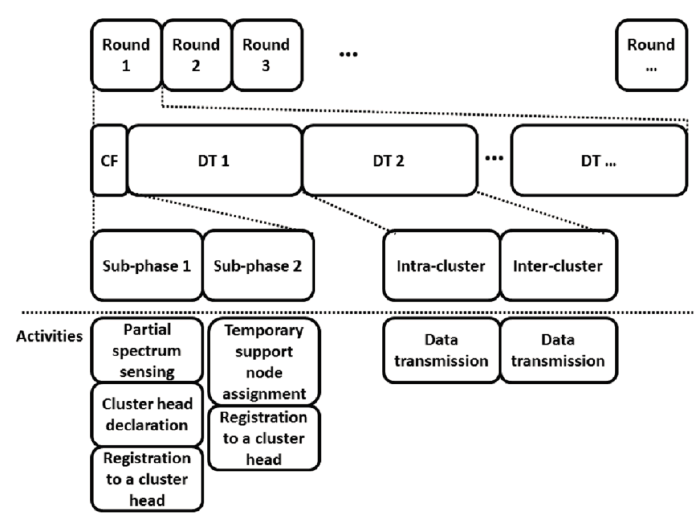
rounds. (CF: cluster formation, DT: data